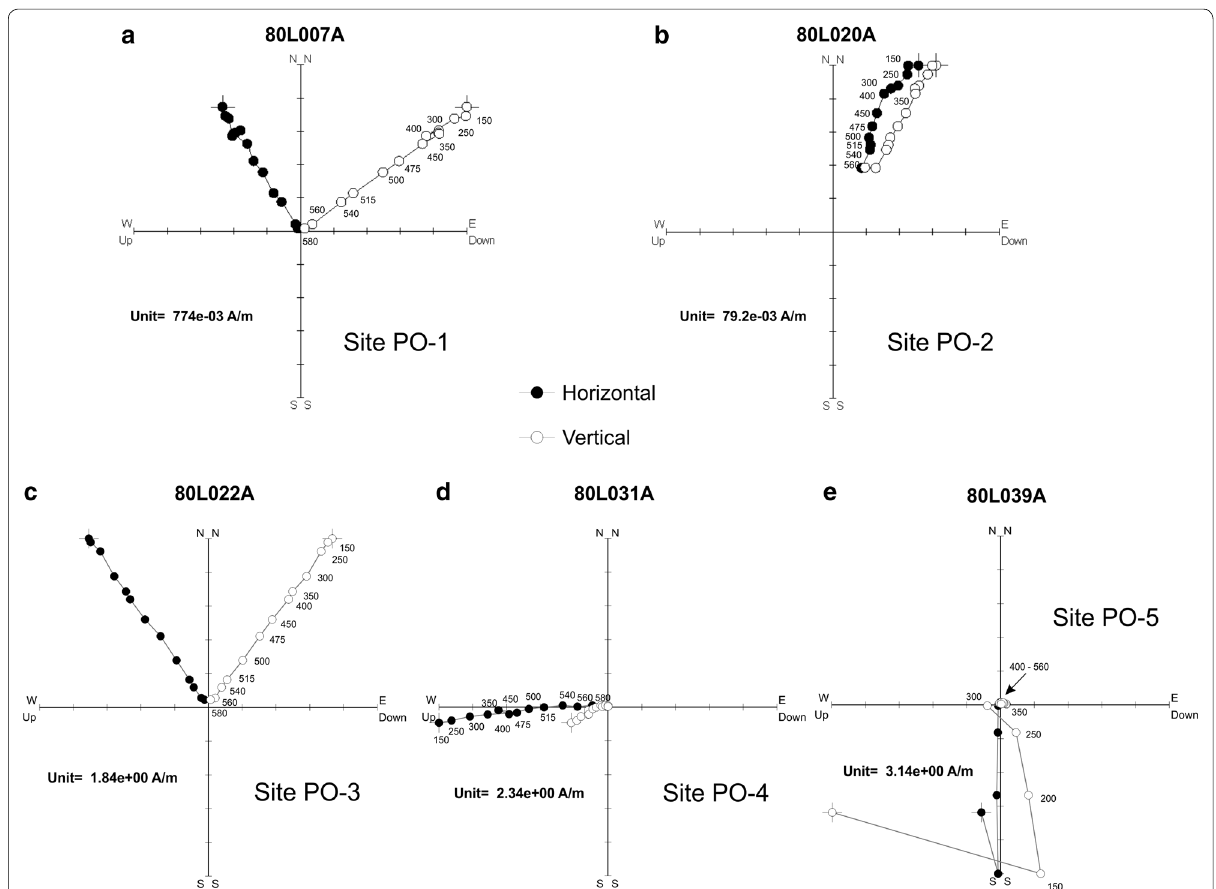
Fig. 13 Representative normalized orthogonal vector plots (Zijderveld diagrams) of stepwise thermally demagnetized samples from a site PO‑1, b site PO‑2, c site PO‑3, d site PO‑4 and e site PO‑5. Labels along horizontal curves denote the temperature during the demagnetization step. See text for more